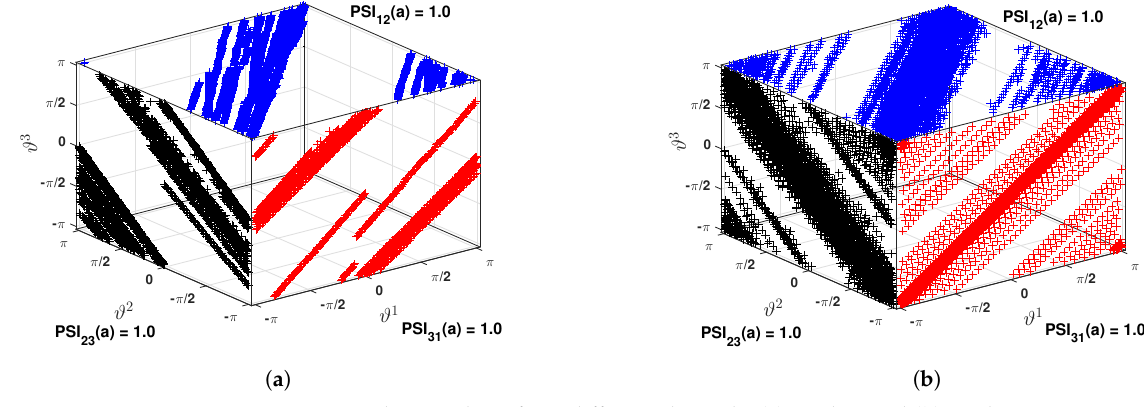
Figure 16. Phase and PSI from different channels: ( a ) mode 2 and ( b ) mode